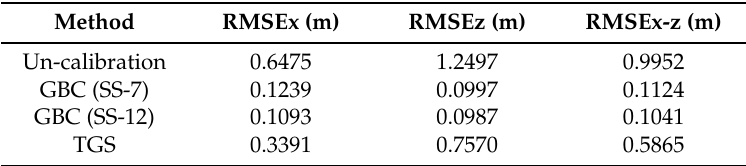
Table 3. Quality of boresight calibration.